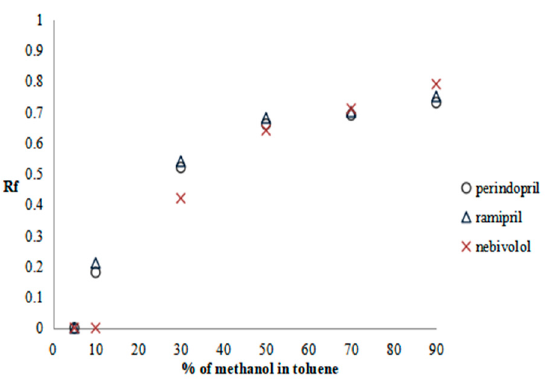
Figure 3. Plots of substance retention relationships vs. the mobile phase composition for the third group of drugs. Stationary phases: HPTLC diol F 254 .